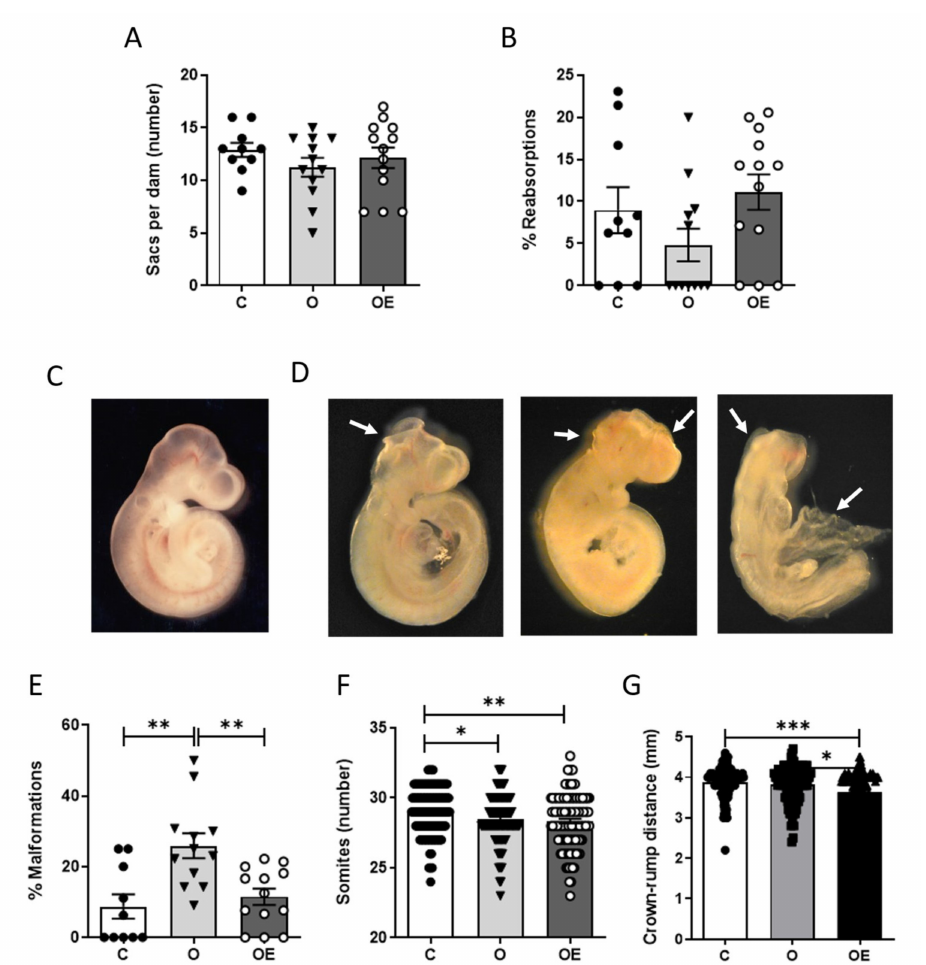
Figure 2. Vitamin E supplementation prevents obesity–induced malformations. After 13 weeks of dietary treatment, rats were mated. During gestation, corresponding diets were maintained, and vitamin E supplementation was administered daily. Embryos were dissected on day 11.5 of gestation. ( A ) Decidual sacs per dam. ( B ) Rate of resorptions. ( C ) Image of an embryo showing a normal morphology, with proper proportions of cerebral vesicles, complete neural tube closure, com- plete otic and cardiac vesicles and full axial curvature. ( D ) Embryos showing major malformations such as open neural tube (left), lack of cerebral vesicles (middle) or general agenesis of structures (right). ( E ) Rate of major malformations. ( F ) Numbers of somites/embryo ( G ) Crown-rump distances. Results are represented as mean + SEM.* p < 0.05; ** p < 0.01 *** p < 0.001. C: Black circles; O: Black triangles; OE: white